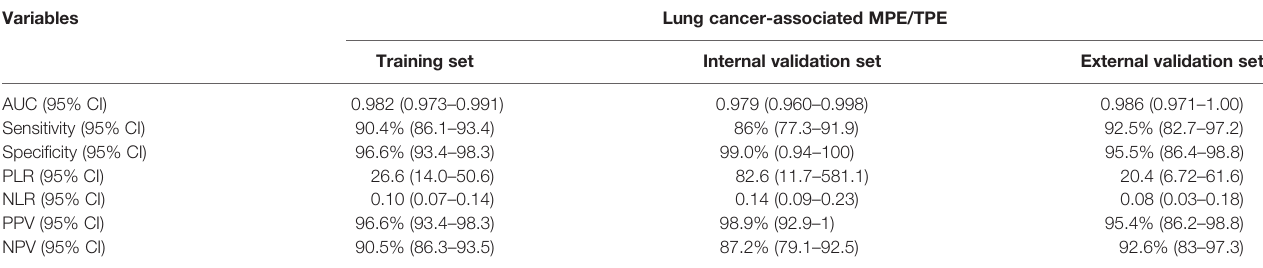
TABLE 5 | Accuracy of the prediction score of the nomogram for differentiating lung cancer-associated MPE from TPE. Variables